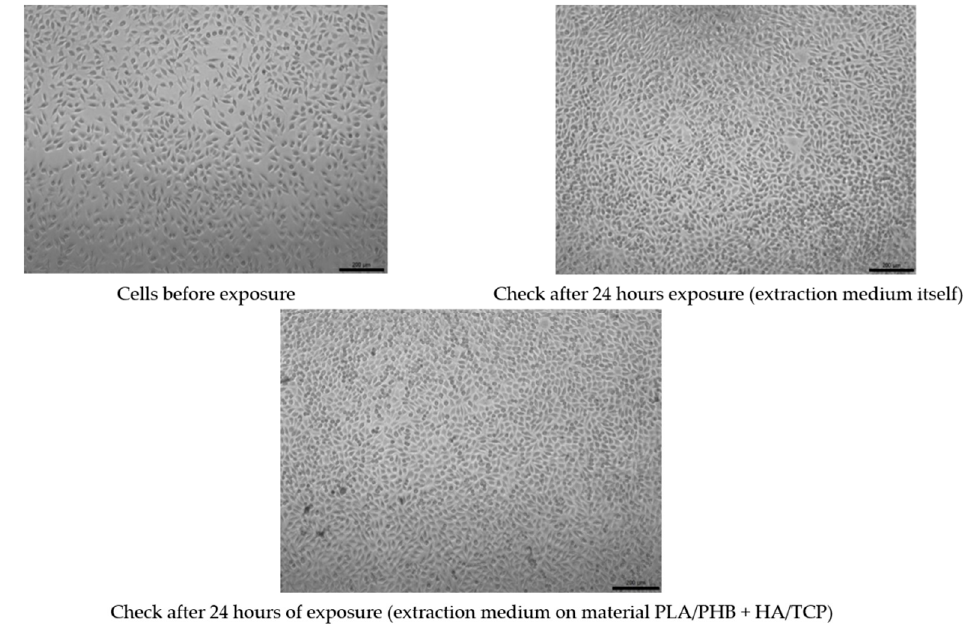
Figure 10. Quantitative imaging of cell culture (check vs. 24 hrs.